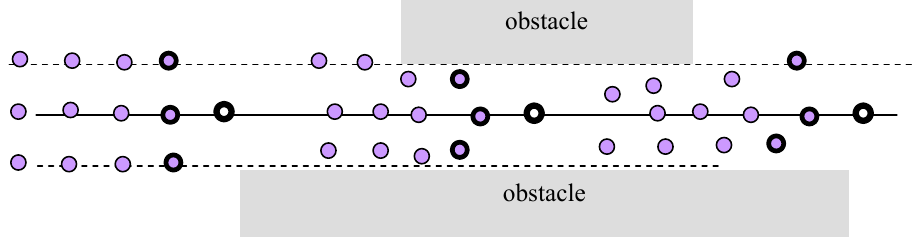
Figure 12. The results of the simulation for scenario 3.